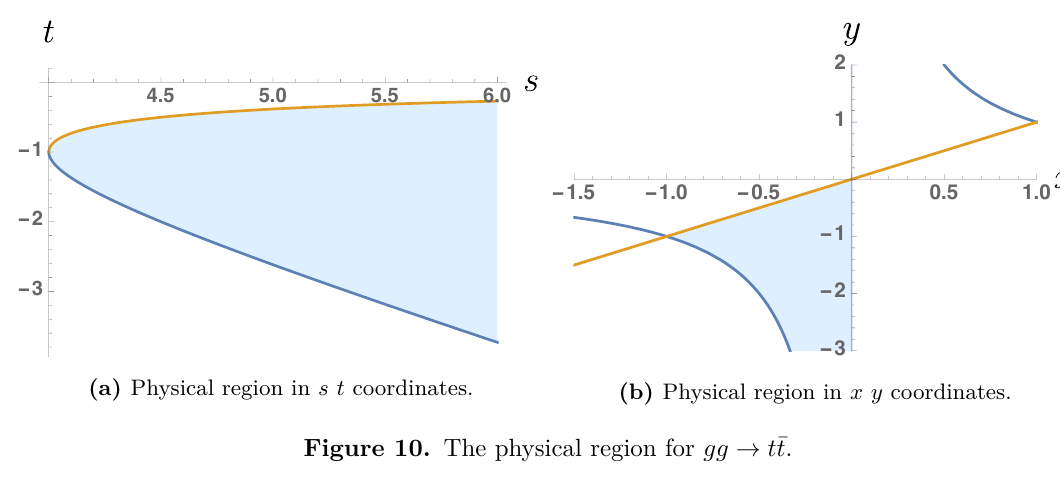
Figure 10. The physical region for gg → t ¯ t